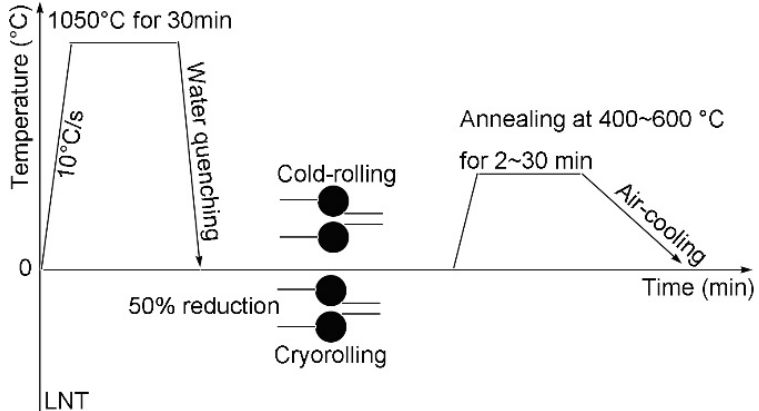
Figure 1. Experimental route to fabricate low ‐ carbon ultrafine grain steel.